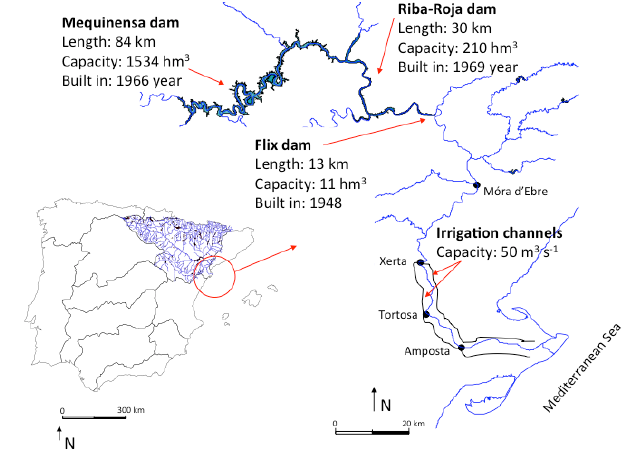
Figure 1. The Ebro River basin in Spain. Location and drainage network (left), the final reach of the river and the Ebro Delta in the Mediterranean Sea (right) with location of dams and main irrigation channels.